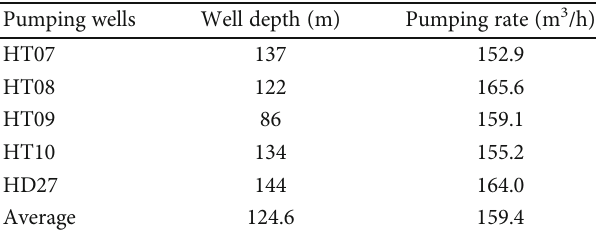
Figure 3: Schematic diagram showing locations of pumping and observation wells. The colored contours give the distributions of drawdown calculated by the multiwell analytical solution with the best fi tting K value of 31.51 m/d. Table 1: Key record of the multiple pumping wells. Pumping wells Well depth